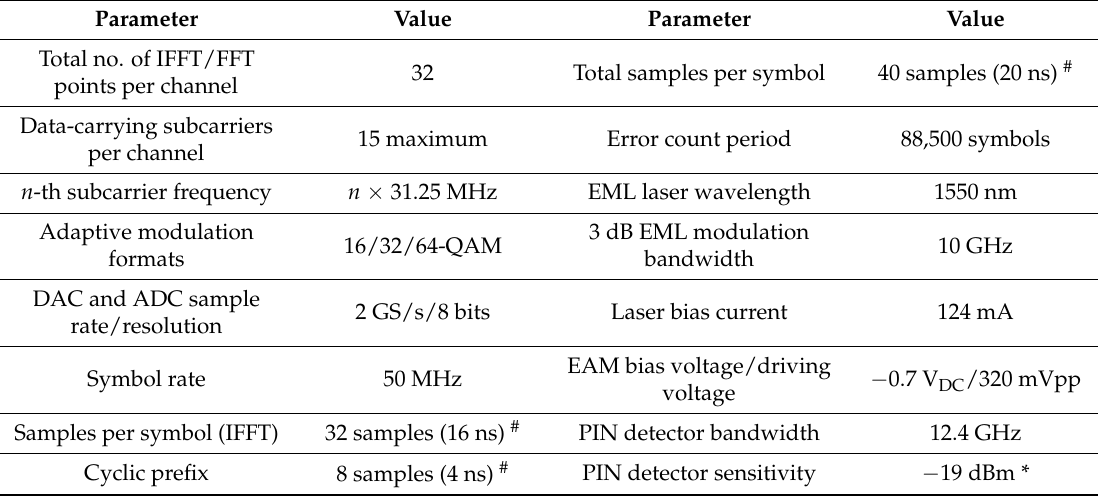
Table 1. Experimental transceiver and system